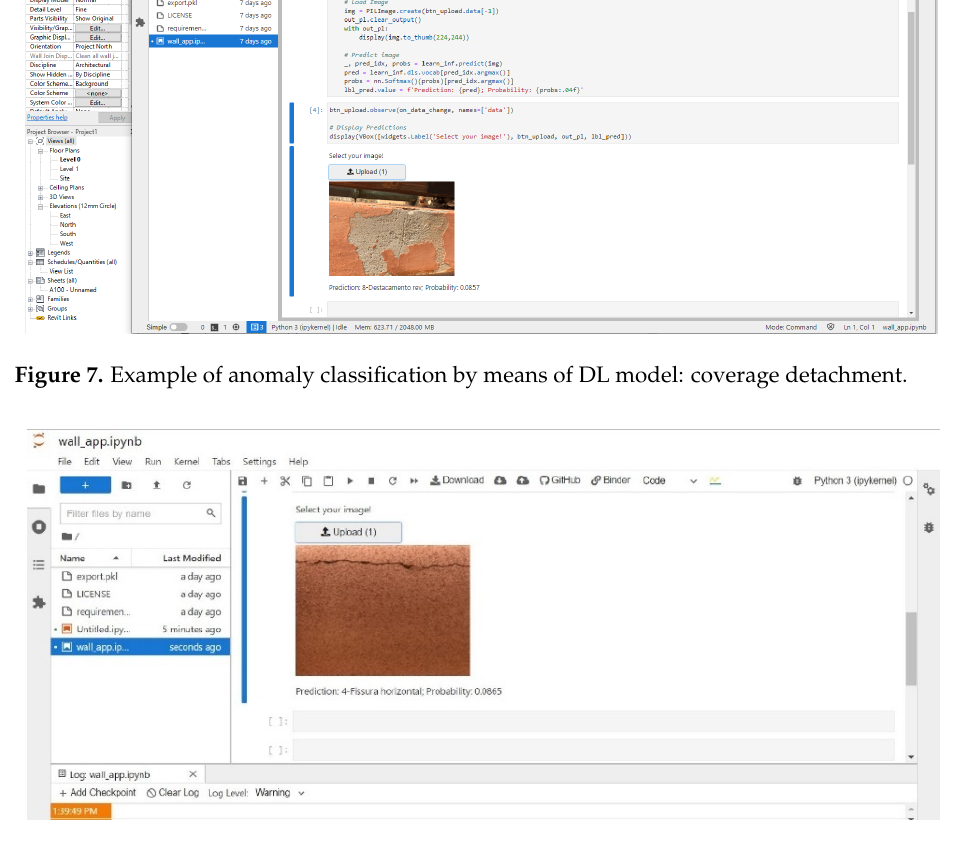
Figure 9. Example of inappropriate anomaly classification by means of DL model: horizontal crack.